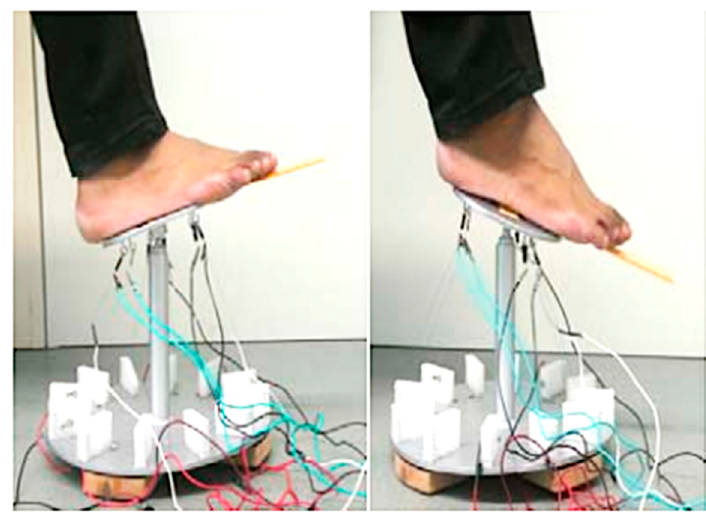
Figure 36. Experimental set up for the SMA wire actuated Stewart platform rehabilitation device [61].